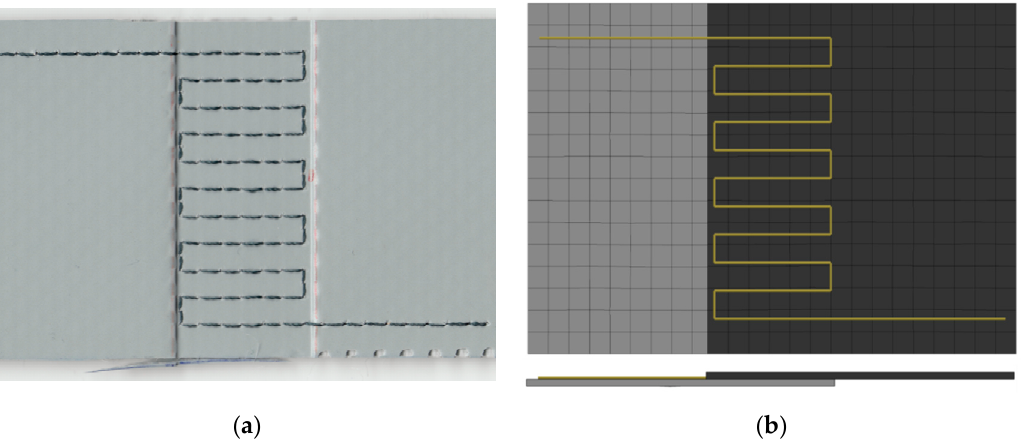
Figure 5. Finite element analysis (FEA) model of sensor thread attached to welded membrane samples: ( a ) Welded membrane with sensor thread; ( b ) model of welded membrane with sensor thread.